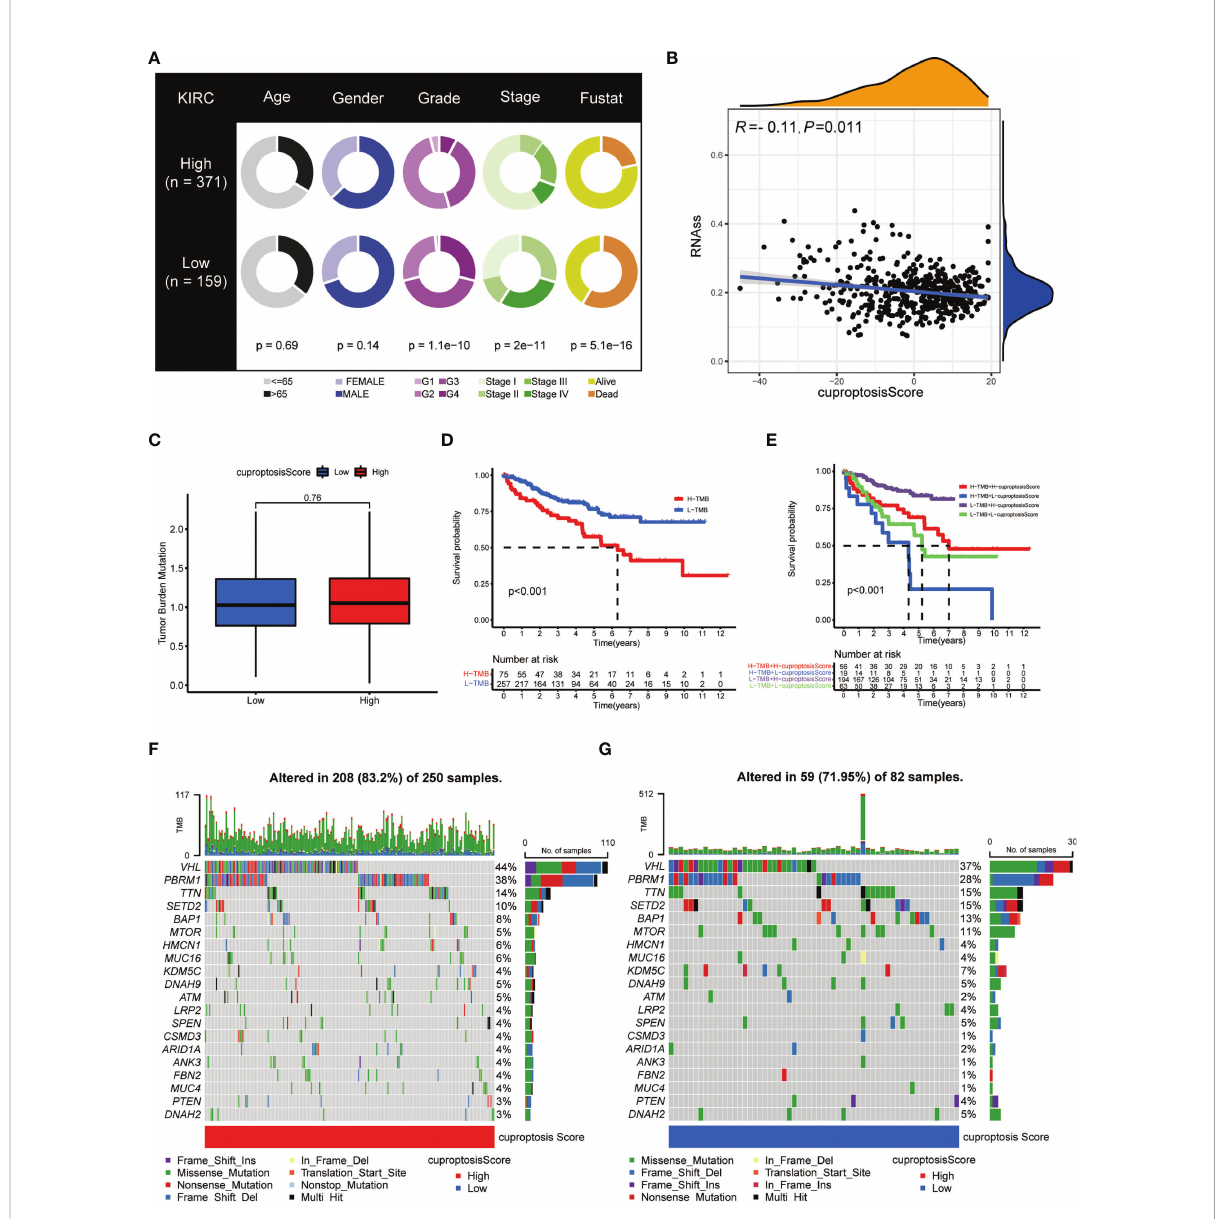
FIGURE 8 Clinical and genetic correlation of cuproptosis score. (A) Clinicopathological information of ccRCC patients in low and high cuproptosis score groups. (B) Spearman ’ s correlation analysis on cuproptosis score and stem cell level. (C) Relationships between cuproptosis score and TMB. (D) Kaplan – Meier survival curves of patients with high and low TMB. (E) Kaplan – Meier survival curves of patients with diverse TMB and cuproptosis scores. (F, G) Genetic mutation landscape of patients with high (F) and low (G) cuproptosis scores. TMB, tumor mutation